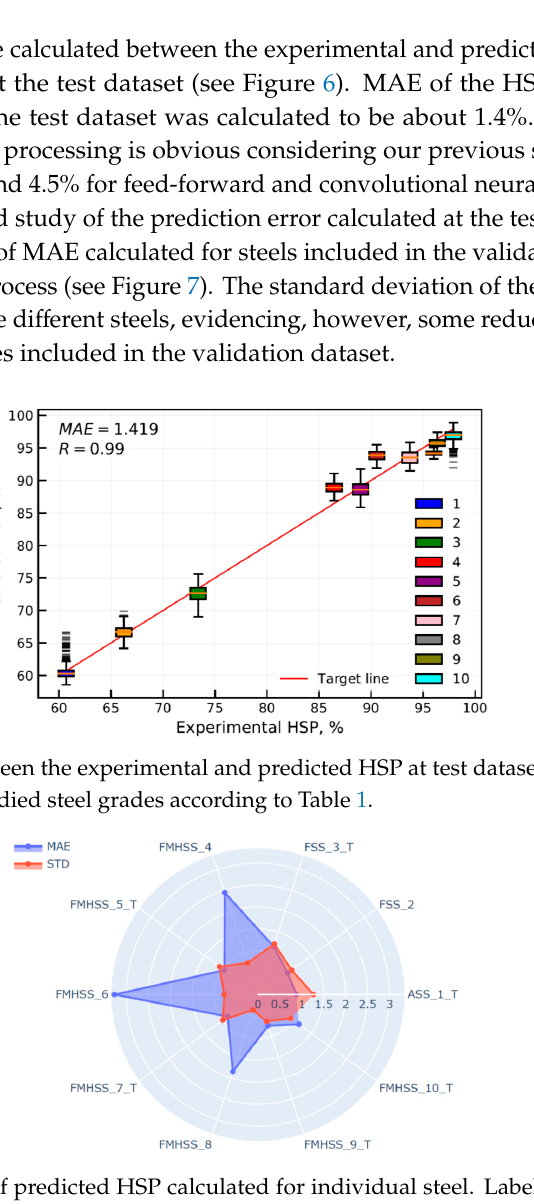
Figure 7. MAE and STD of predicted HSP calculated for individual steel. Labels of the plot denote steel type and ordinal number of the studied steels according to the Table 1. Steel grades presented in the training dataset are marked by the letter T. The dimension is in %.